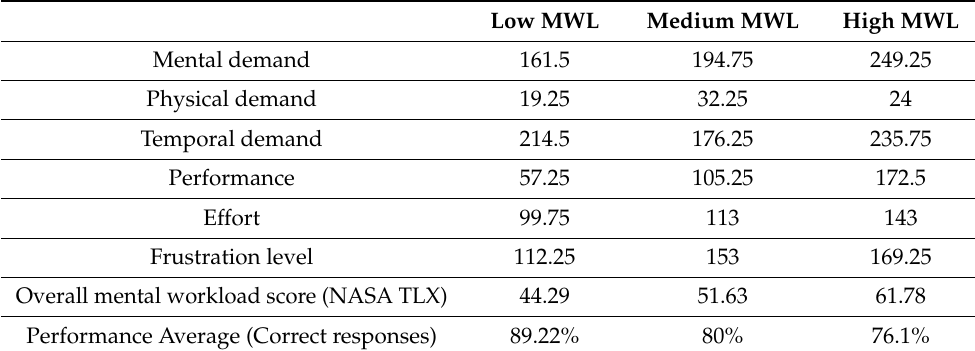
Table 4. NASA-TLX Results.